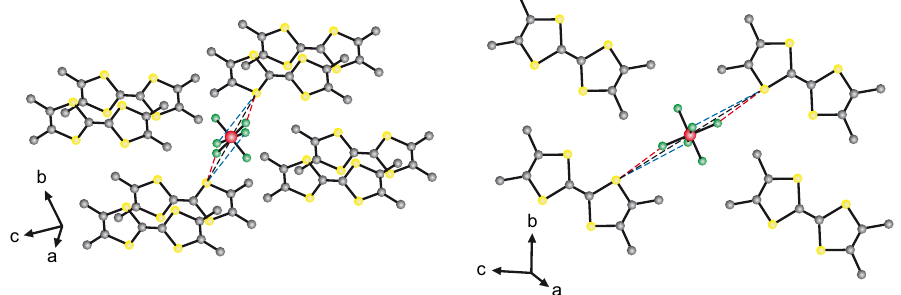
Figure 4. Two views on the crystal structure of (TMTTF) 2 SbF 6 illustrate the confinement of the octahedral anions in a cavity formed by methyl groups (gray) of the surrounding TMTTF molecules. Also shown by dashed lines are the closest connections between the fluorine (green) and sulphur atoms (yellow); the antimony ion (red) is located in the center